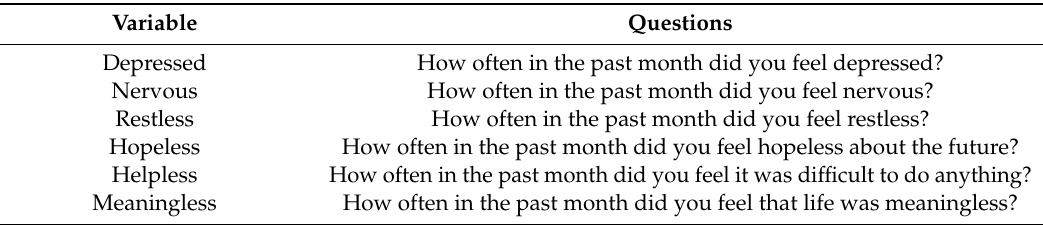
Table 1. Indicators of children’s emotional wellbeing.